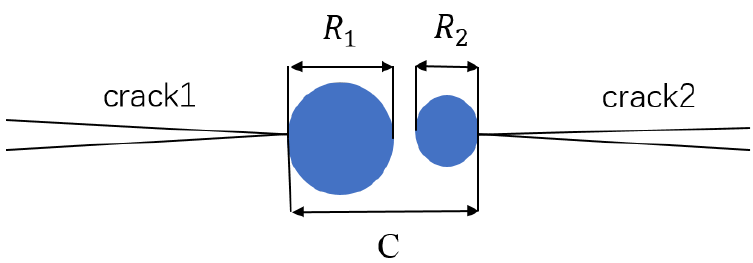
Figure 14. Diagram of plastic zone at crack